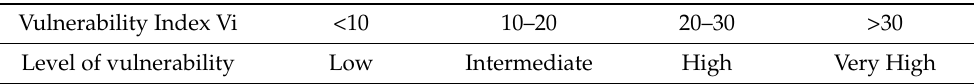
Table 8. Vulnerability index Vi grouped into four levels of vulnerability.